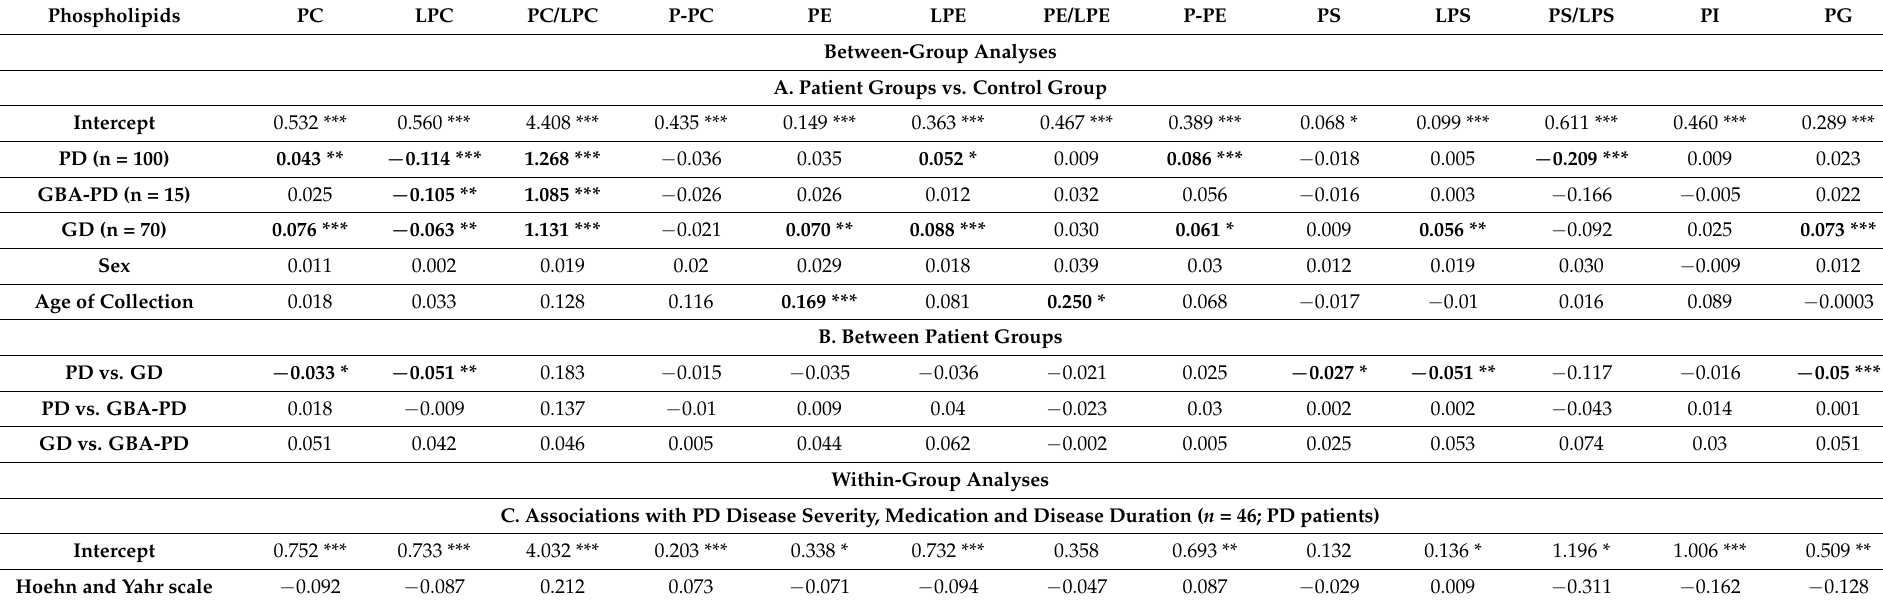
Table 2. Serum lipid level alterations in the Iberian GD and PD